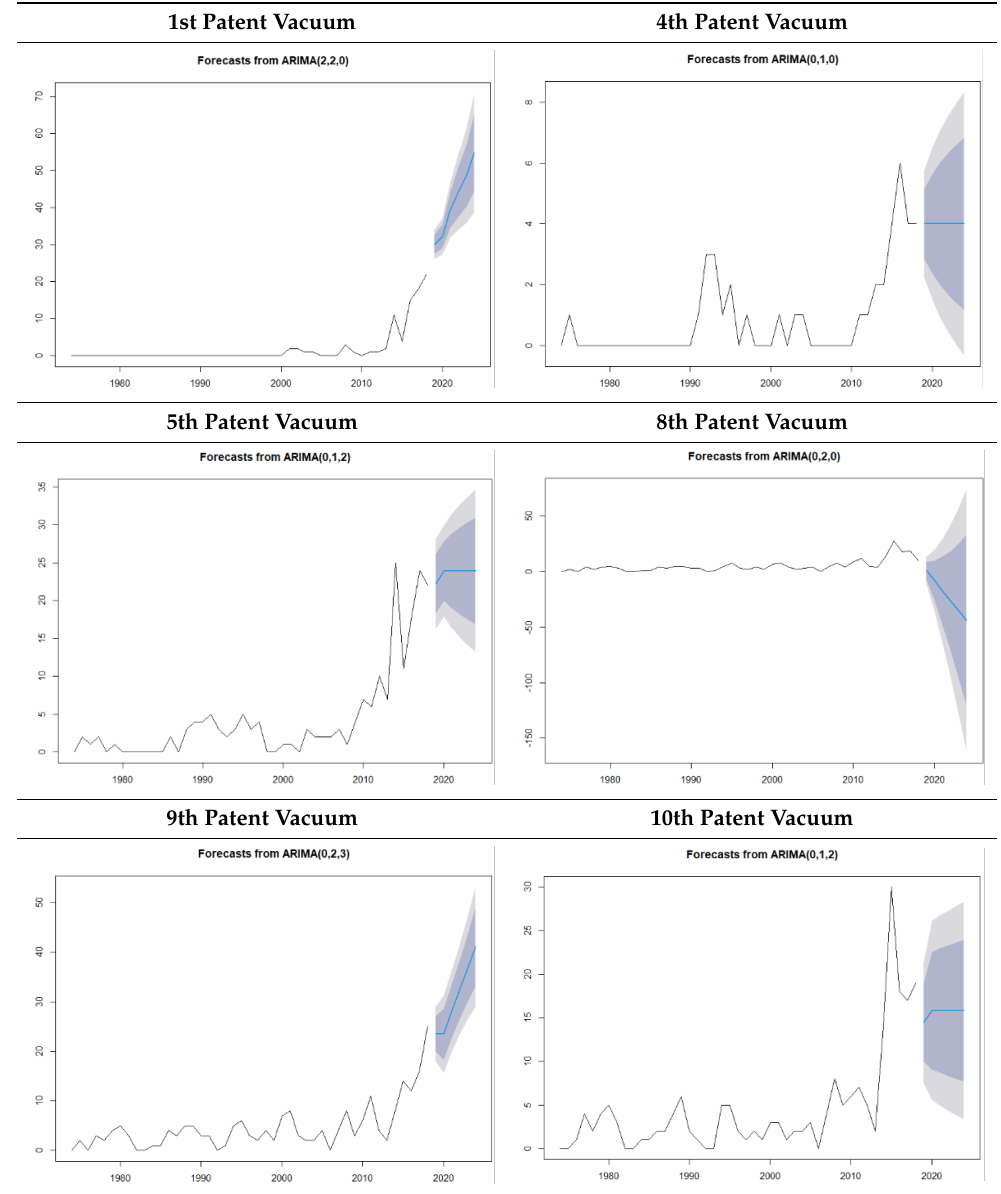
Table 4. Results of the trend analysis using a time series analysis.